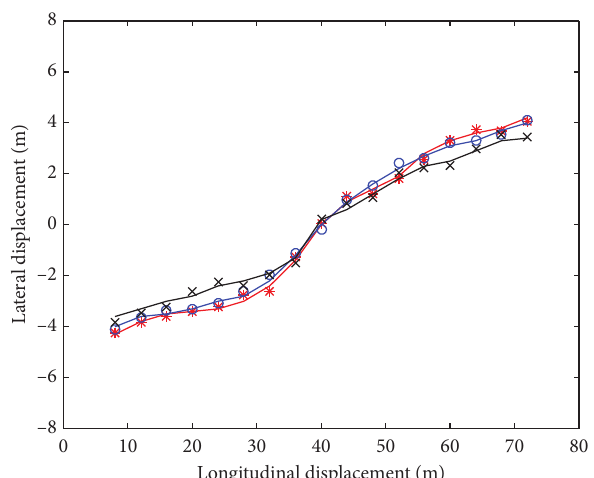
Figure 3: Actual test data and simulation data of left lane change.